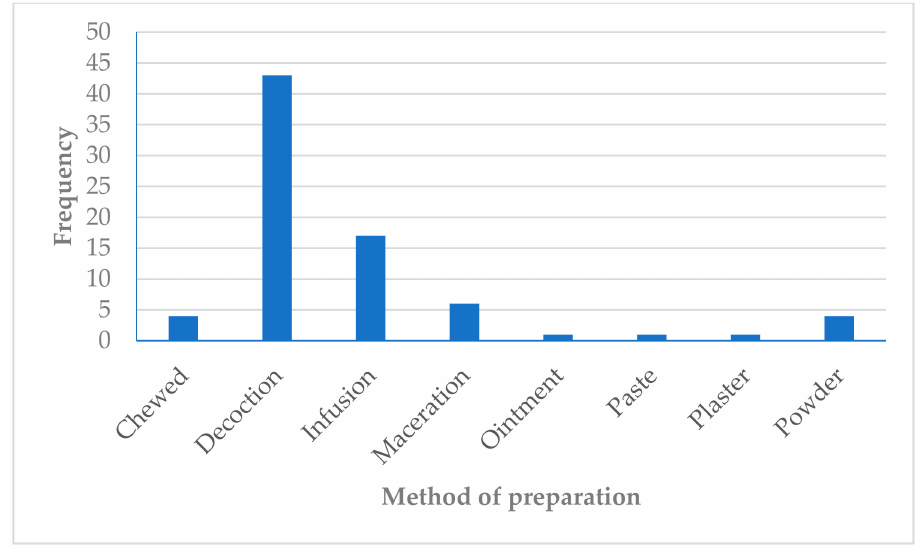
Figure 4. Frequency ( n ) for the method of preparation of medicinal plants used in the management of headache in